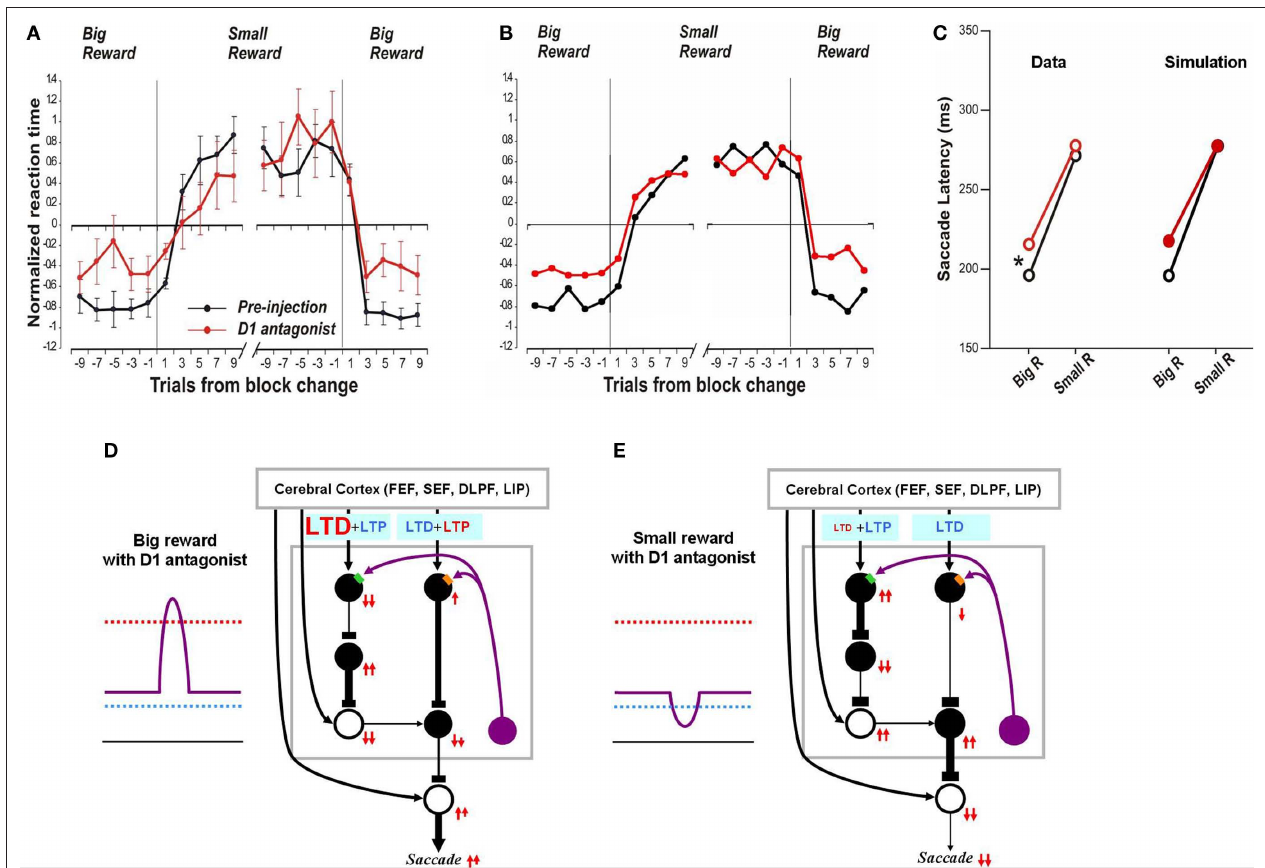
big-reward trials. The D1 antagonist effectively elevates the D1 threshold and therefore induces a smaller-than-usual LTP in the direct pathway MSNs, whereas the indirect pathway MSNs are unaffected. The attenuated LTP leads to a weaker activation of the SC and therefore a longer latency saccade. (e) Hypothesized mechanism of the effect of D1 antagonist in big-reward trials. The DA level remains below the D1 threshold similarly to the control condition ( Figure 2D ) and therefore the saccade latency is not